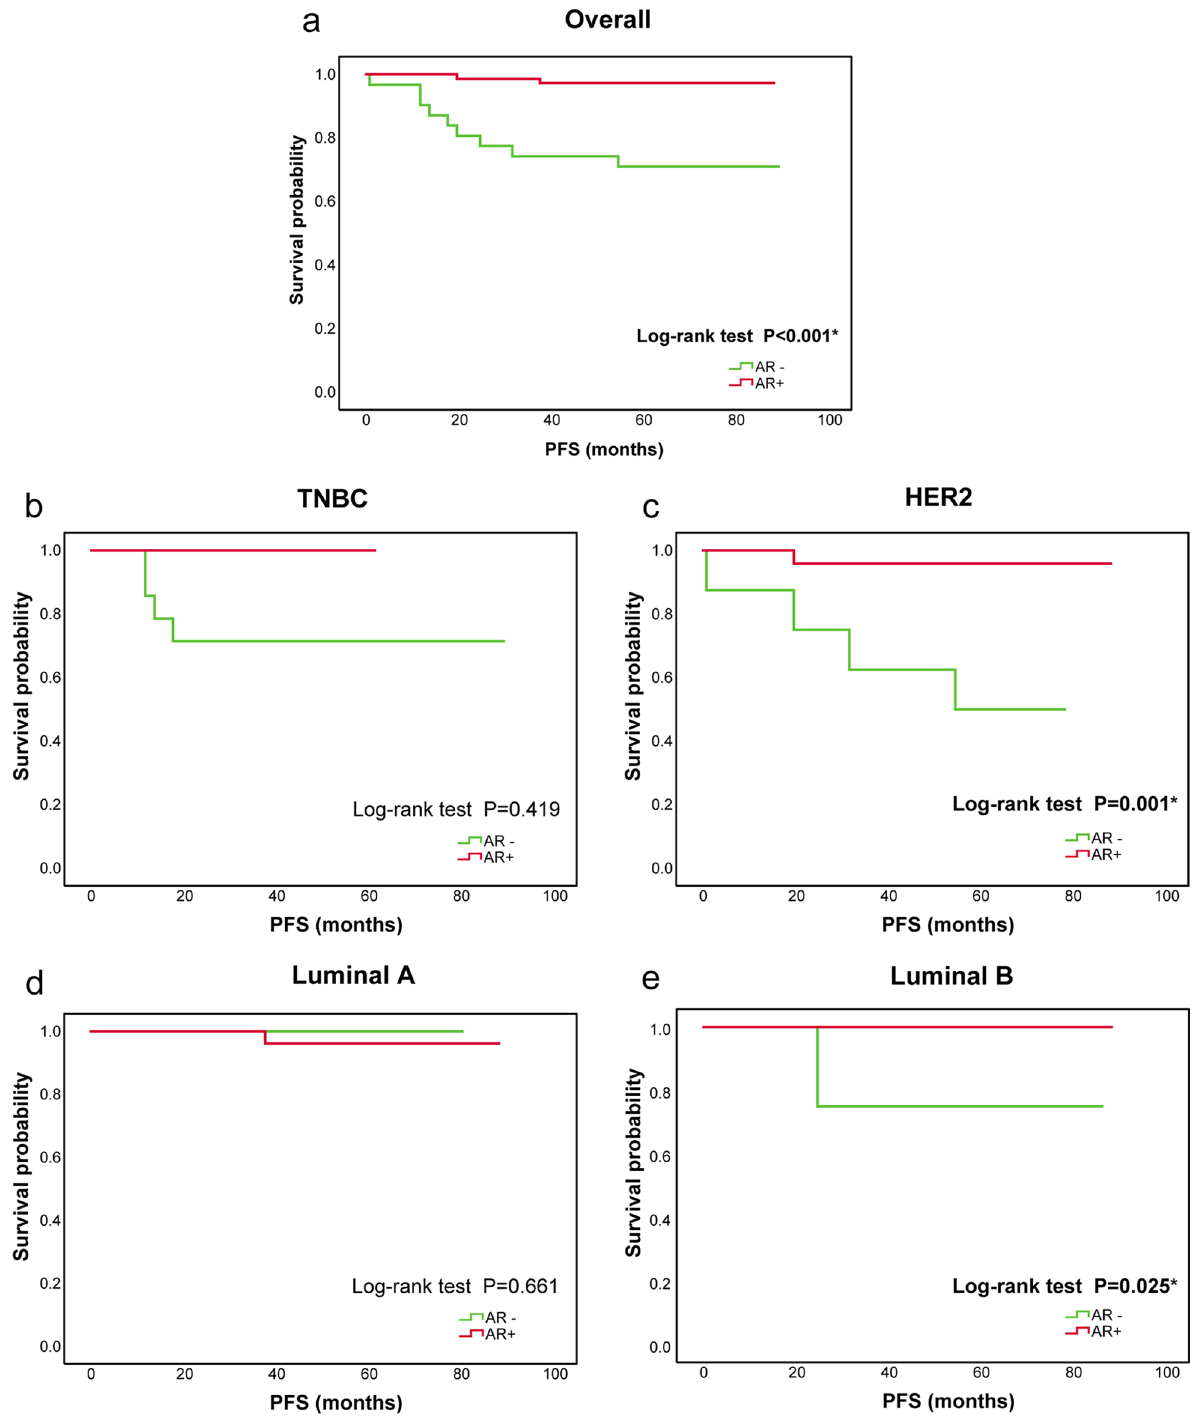
Fig. 6 Prognostic role of AR in different breast cancer patients. a Overall patients ( n (29.03%,9/31) in the AR- group experienced disease progression. b TNBC patients( n (28.57%,4/14) in the AR– group experienced disease progression. c HER2 overexpression subtype patients( n AR group versus 4 cases (50%,4/8) in the AR- group experienced disease progression. d Luminal A subtype patients( n + the AR group versus no patient (0/5) in the AR– group experienced disease progression. e Luminal B subtype patients( n + in the AR group versus 1 case (25%,1/4) in the AR– group experienced disease progression. TNBC , triple negative breast cancer; HER2 , human + epidermal growth factor receptor 2; AR , androgen receptor; PFS , progression-free survival; * indicates p <